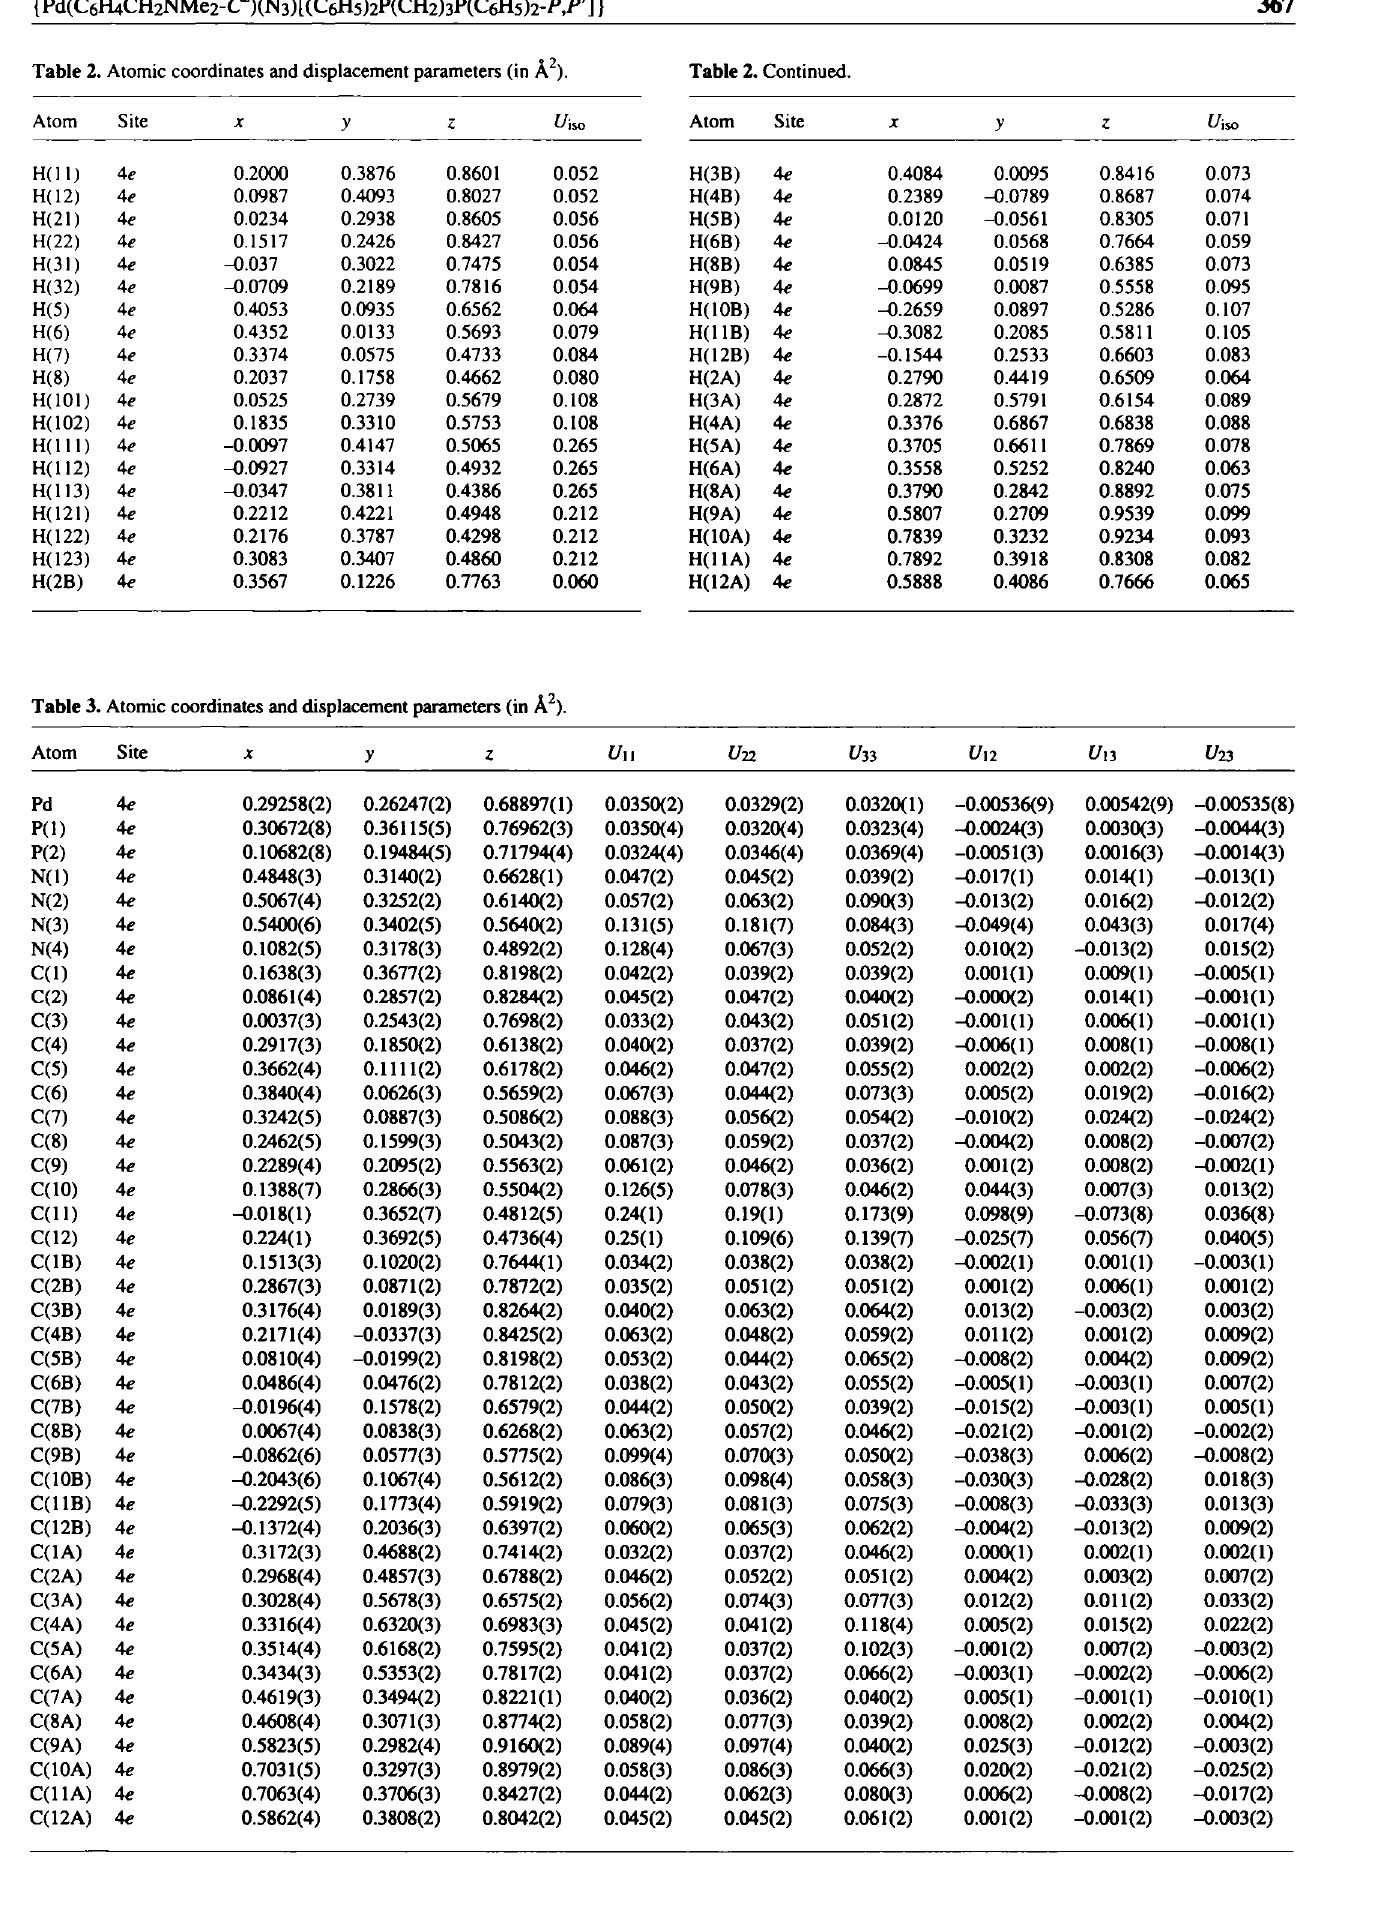
Table 2. Atomic coordinates and displacement parameters (in Â 2 ). Table 2. Continued.